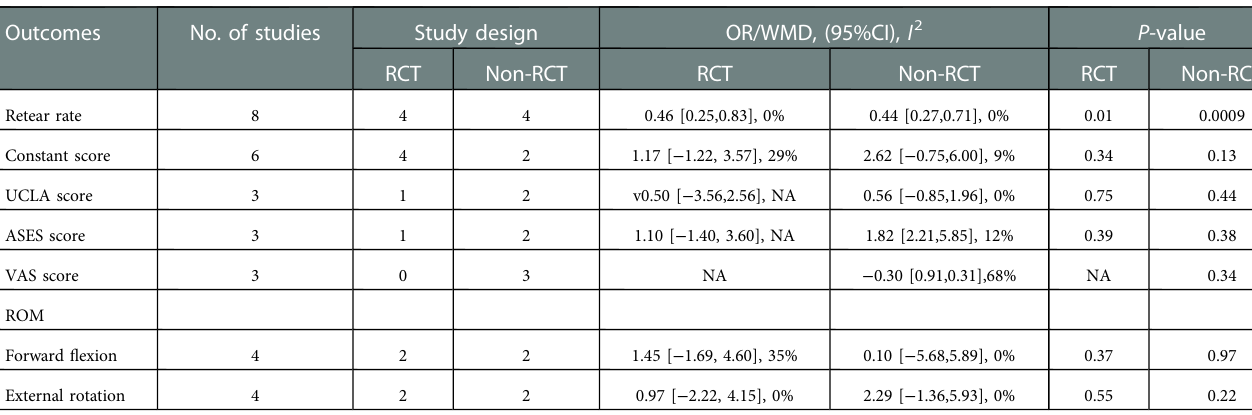
TABLE 4 Subgroup analyses according to study